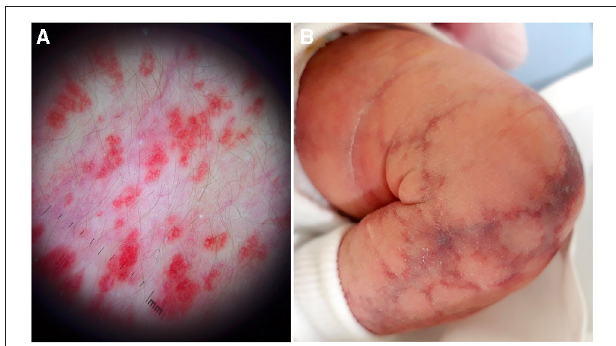
FIGURE 8 | Dermoscopy of a flat infantile hemangioma shows a micro-papular pattern and allows to differentiate it from capillary malformation (A) . Cutis marmorata telangiectatica congenital with the typical reticulated linear atrophy (B) .